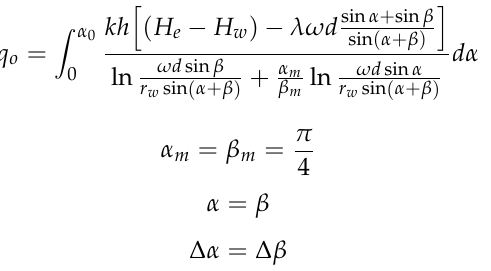
Figure 10. Diagram of the effective utilization factor.